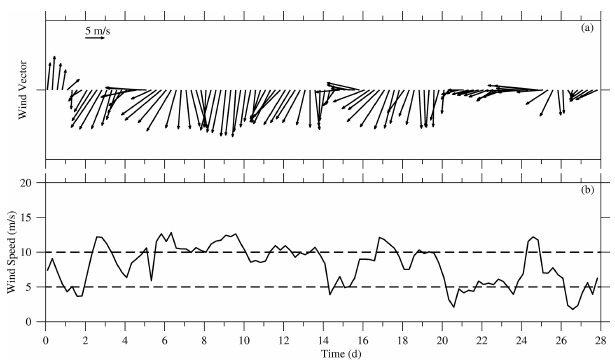
Figure 10. Temporal variations in wind vector (a) and speed (b) in February 2014 as simulated by WRF.